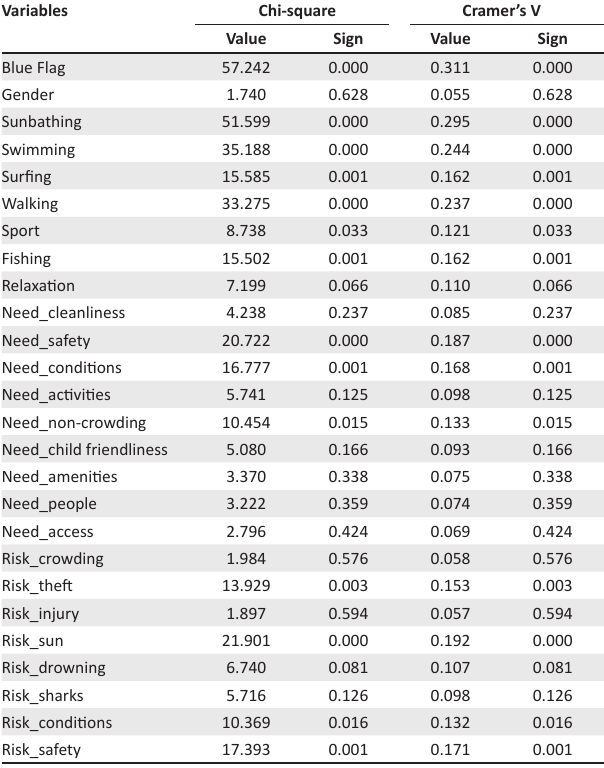
TABLE 4-A1: Summary of chi-squared and Cramer’s V test